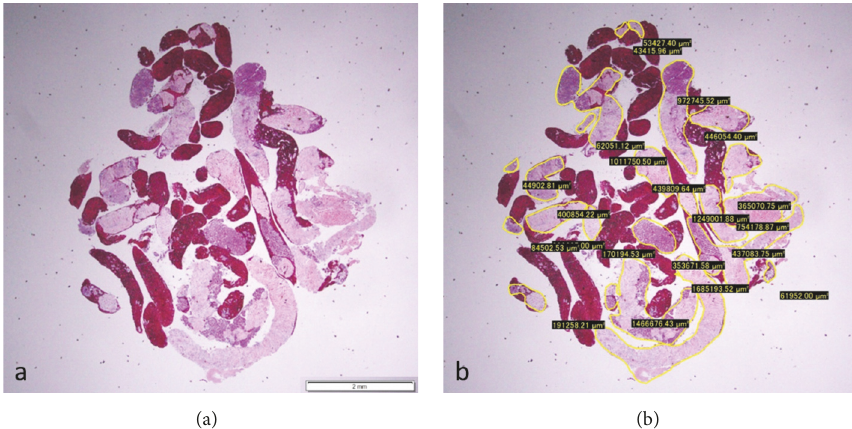
Figure 2: (a) Hematoxylin and eosin staining of a gross specimen obtained from the pancreas using a 22-gauge Franseen needle, viewed in a low-power field. (b) Measuring the area of the specimen, excluding the blood clots, using imaging software